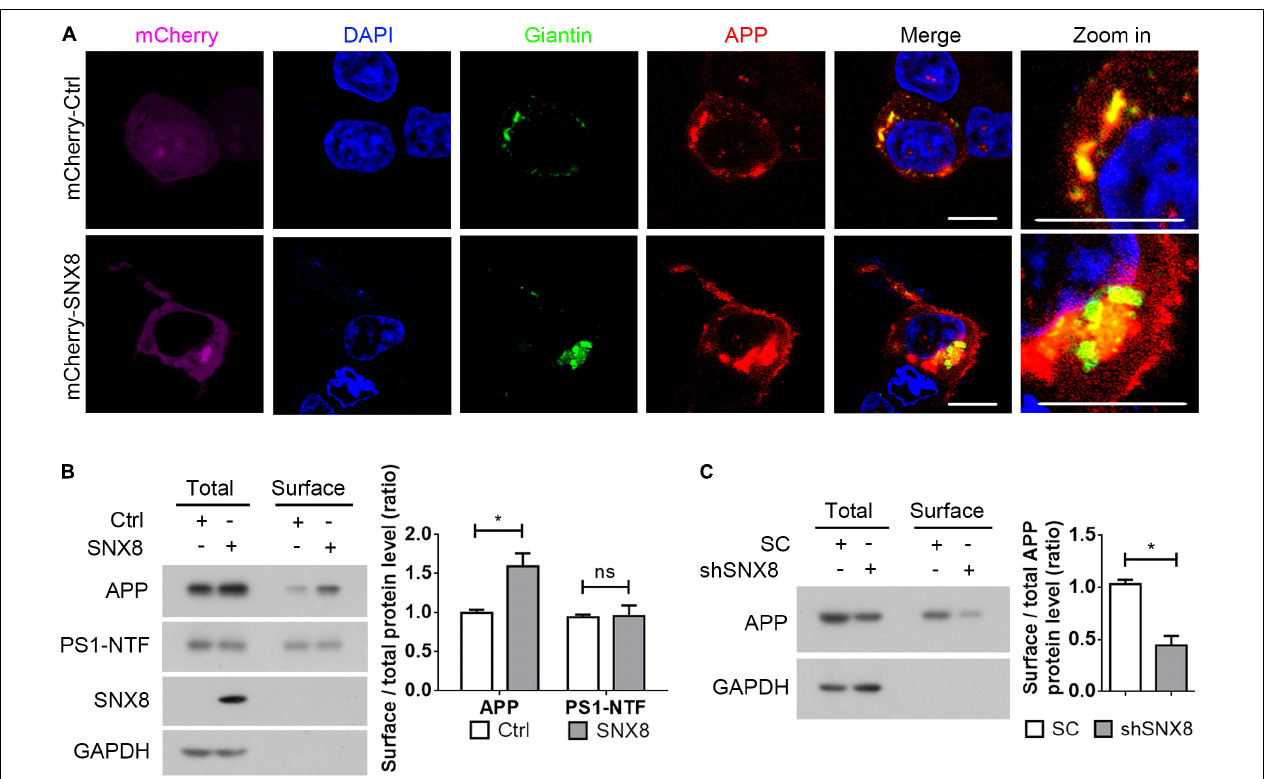
FIGURE 5 | SNX8 Regulates APP Trafficking to the Cell Surface. (A) HEK293T cells were co-transfected with APP-myc and mCherry control (mCherry-Ctrl) or mCherry-SNX8 vectors for 24 h. Cells were permeabilized, fixed, immunostained with antibodies against myc (to detect APP, red-pseudo color) and Giantin (to detect Golgi, green-pseudo color), and stained with DAPI (blue). Images were acquired by fluorescence microscopy. mCherry was shown in magenta (pseudo color). Scale bars, 10 µ m. (B) HEK293T cells were co-transfected with APP-myc and SNX8-myc (SNX8) or control (Ctrl) vectors for 24 h, and subjected to cell surface biotinylation. Biotinylated cell surface components were precipitated from cell lysates with streptavidin-agarose beads. Cell surface biotin-labeled APP, PS1-NTF, and inputs from the cell lysates were detected by Western blotting. Cell surface APP (or PS1-NTF) and total APP (or PS1-NTF) intensities were quantified by densitometry, and the ratio of cell surface APP (or PS1-NTF) levels to total APP (or PS1-NTF) levels was compared to the control ratio (set to 1.0). n = 4, ∗ p < 0.05, ns: not significant, Mann–Whitney U test. (C) HEK293T cells were transfected with APP-myc and scrambled control (SC) or SNX8 shRNA (shSNX8) vectors for 48 h. After cell surface biotinylation, biotinylated proteins were precipitated for Western blotting. Cell surface APP and total APP intensities were quantified by densitometry, and the ratio of cell surface APP levels to total APP levels was compared to the control ratio (set to 1.0). n = 4, ∗ p < 0.05, Mann–Whitney U